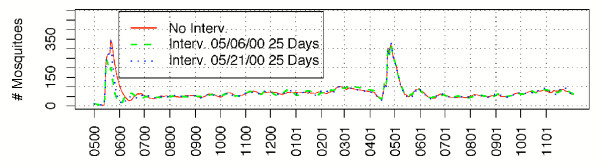
An. gambiae adult abundance with adult control intervention